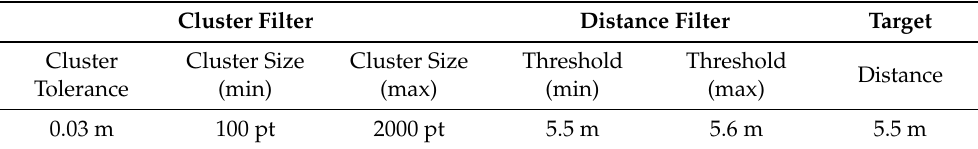
Table 2. Filter parameters.